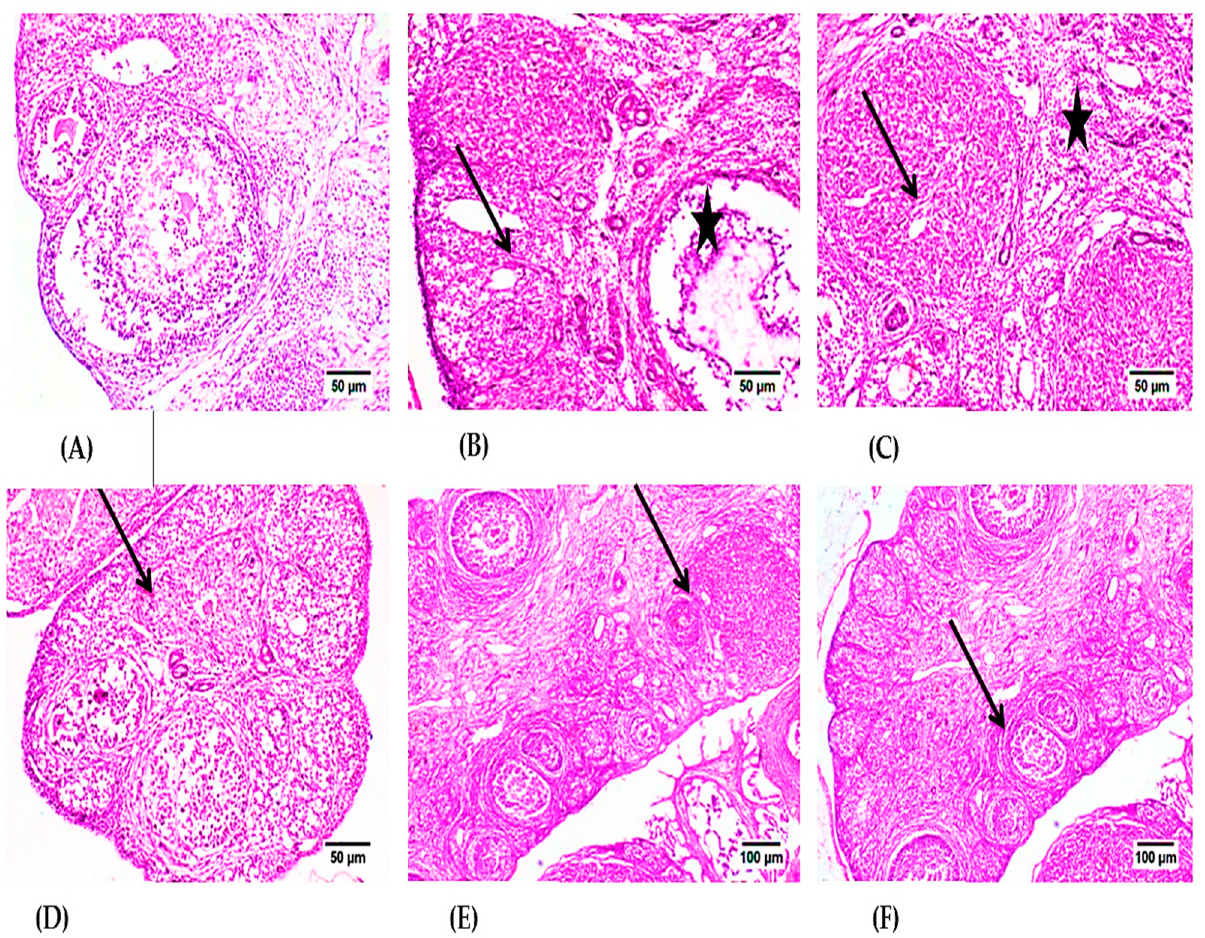
Figure 4. Photomicrographs of H- and E-stained ovarian tissue sections of the control and experi- mental groups. ( A ) control group, showing normal Graafian and secondary follicles. ( B ) CPA-treated group showing luteal structure (arrow) and Graafian follicle (star) with mild mononuclear inflammatory cell infiltration. ( C ) CPA-treated group showing the luteal structures (stars) and the intense interstitial inflammatory reaction (arrow). ( D ) The LPE-treated group displays various stages of progressing follicles with the existence of inflammatory cell infiltration. ( E ) The RES-treated group showed normal developing follicles with mild inflammatory edema. ( F ) The RES + LPE-treated group showed apparently normal ovarian tissue. CPA: Cyclophosphamide, LPE: Lemon peel extract, RES: resveratrol.